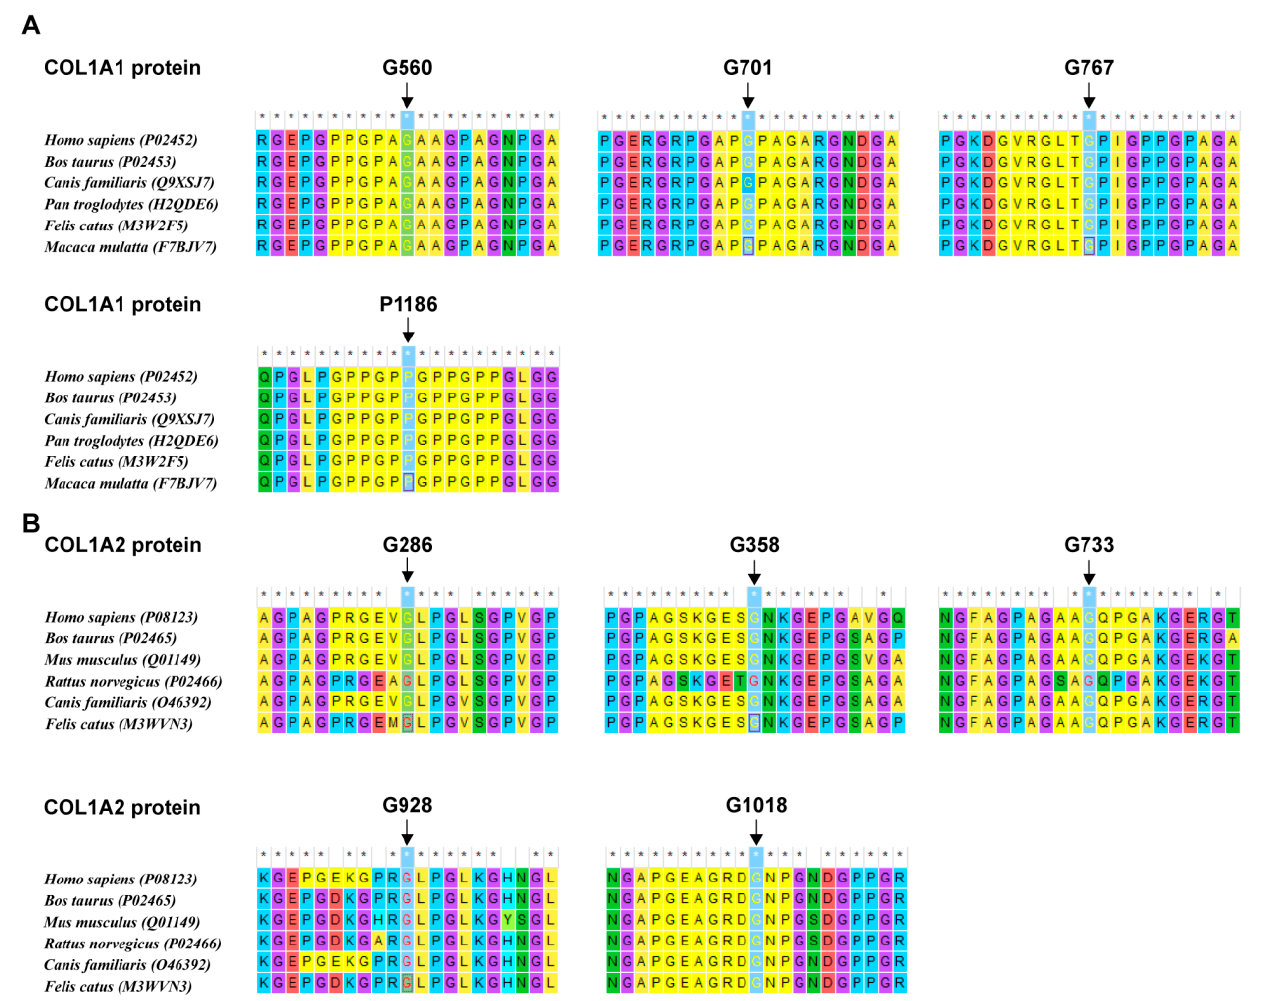
Figure 4. The evolutionaryconservatism of AA residues affected by nine missense variants in the COL1A1/2 genes identified in this study. ( A ) Conservatism of the residues in COL1A1 affected by missense variants detected in this study. ( B ) Conservatism of the residues in COL1A2 affected by missense variants detected in this study.